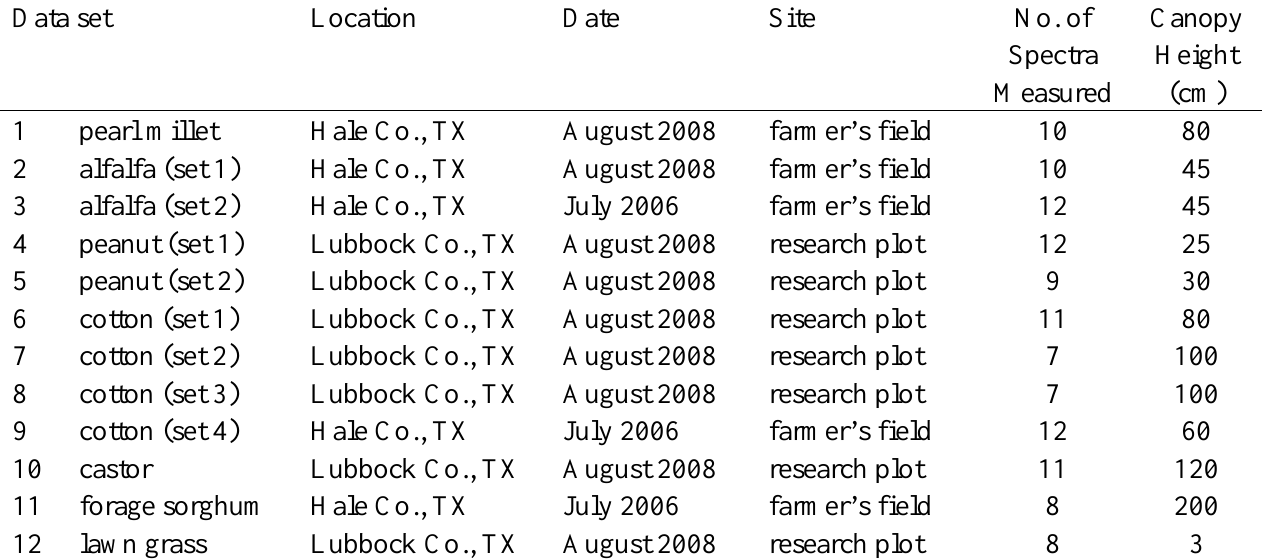
Table 2. The seven plant species used in the study for determining canopy